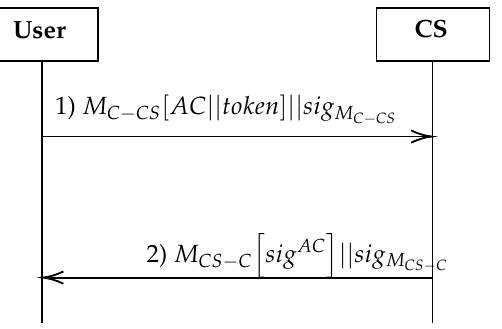
Figure 3. Sequence diagram for the communication between the user and CS.